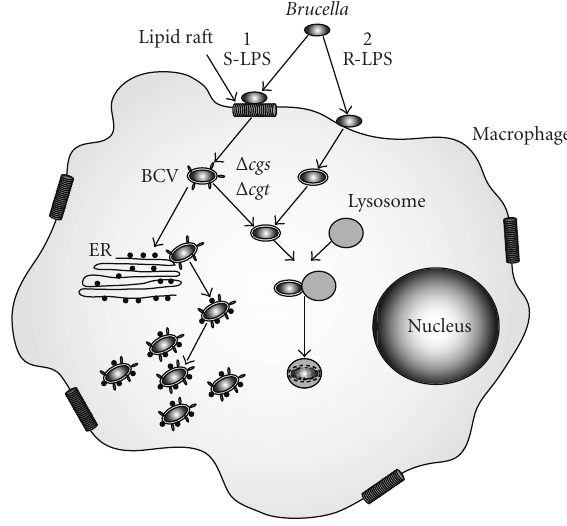
Figure 1: The Brucella -macrophage interaction. The preferred cells infected by Brucella are macrophages. Brucella strains with smooth LPS (S-LPS) enter the cell through interaction with lipid rafts and are then encompassed in a membrane bound compartment called Brucella containing vacuole (BCV). This vacuole retains some lipid raft markers, targeting the BCV to the endoplasmic reticulum (ER). Brucella fuses with the ER, thus acquiring ER markers to avoid fusion with the lysosome before beginning to replicate. Rough LPS mutants do not enter the macrophage through lipid rafts and are rapidly targeted to the lysosome and killed. Mutants in the C β G biosynthesis pathway ( Δ cgs and Δ cgt ) do not fuse with the ER but are targeted to the